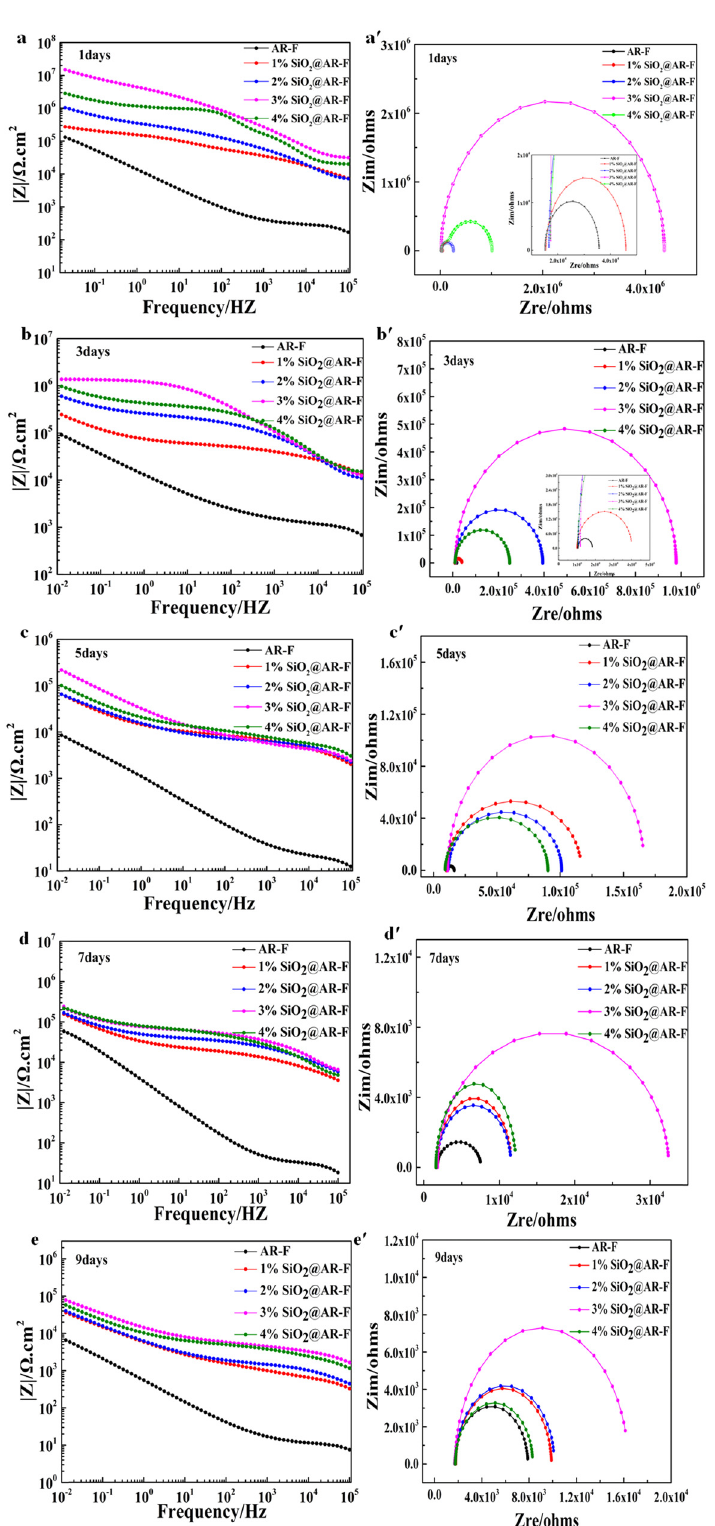
Figure 9: Bode ( a – e ) graph and Nyquist ( a ′– e ′ ) graph of coating under di ff erent immersion time: 1 ( a, a ′ ) , 3 ( b, b ′ ) , 5 ( c, c ′ ) , 7 ( d, d ′ ) , and 9 days ( e, e ′ )